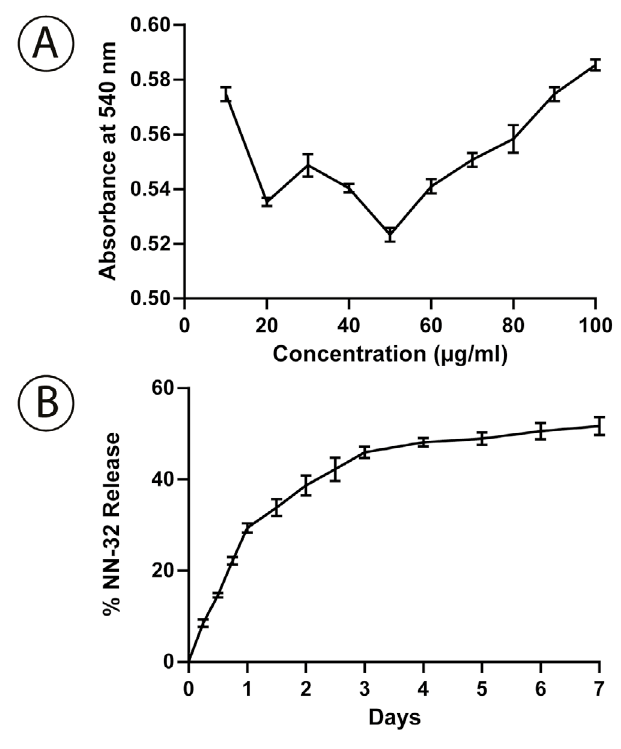
Figure 5. (A) Estimation of NN-32 per GNP. (B) In vitro NN-32 release profiles from GNP. GNP-NN-32 showed biphasic release kinetics.